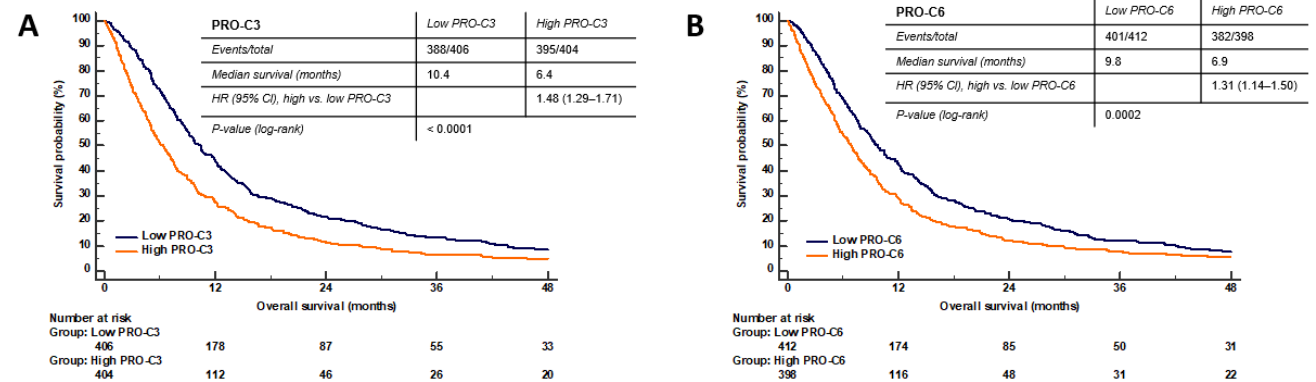
Figure 5. Kaplan-Meier plots showing the association between PRO-C3 ( A ), PRO-6 ( B ) and overall survival in patients with pancreatic ductal adenocarcinoma (stages 1–4, n = 810). Blue line: low biomarker levels ( ≤ median). Orange line: High biomarker levels (>median). Hazard ratios (HR), 95% confidence interval (CI) and log-rank tests are shown. A p < 0.05 was considered significant. Table 2. Association between biomarker levels, clinical covariates and outcomes for patients with pancreatic adenocarcinoma (PDAC), stage 1–4. Uni- and multivariate Cox regression analyses were used to calculate the hazard ratios (HR) with 95% Cl and p -values. A p < 0.05 was considered significant. * kombi: combination of PRO-C3 and PRO-C6 in three groups: (1) low PRO-C3 and low PRO-C6 (LL); (2) low PRO-C3 and high PRO-C6 or high PRO-C3 and low PRO-C6 (LH or HL); and (3) high PRO-C3 and high PRO-C6 (HH). Abbreviations: BMI, body mass index; CACI, Charlson